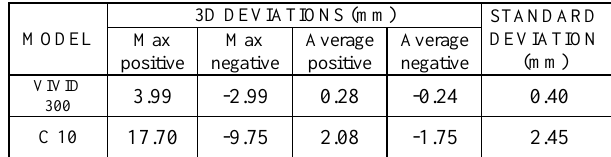
Table 1. points-model from the C10 scans, for the head of